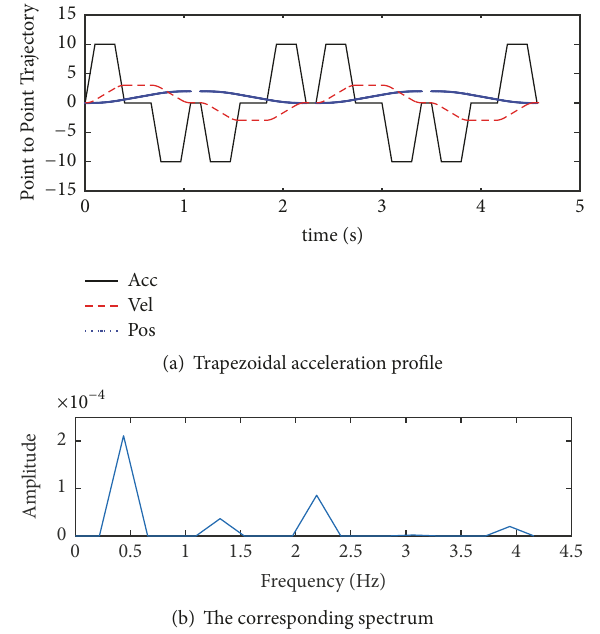
Figure 4: An illustrative example of the trapezoidal acceleration profile and the corresponding spectrum for cyclic